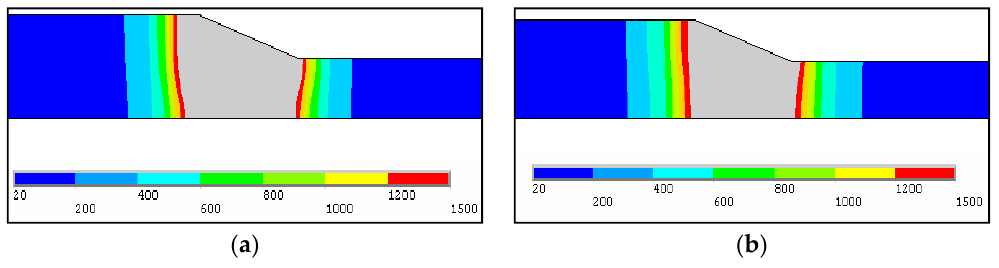
Figure 14. The calculated weld cross-section of the tailored blanks cross-section (2:1 power ratio, 1800 W total power, and 1.2 m/min welding speed): ( a ) The arrangement mode II ( b ) the arrangement mode III.